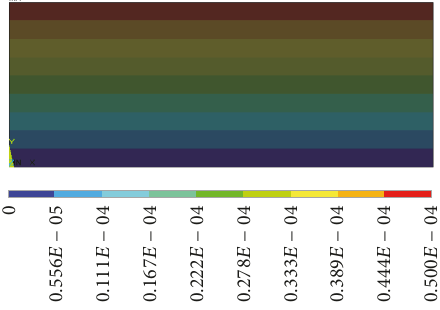
Figure 10: Displacement in the 𝑦 -direction.